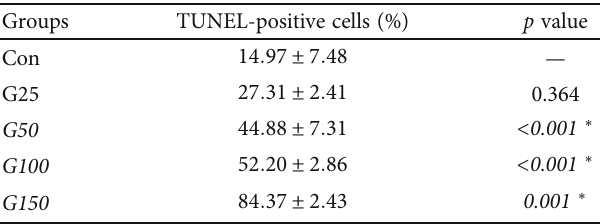
Table 3: TUNEL-positive cells in RGCs using TUNEL staining at 48h.